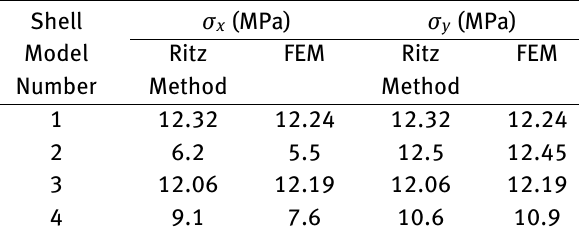
Table 2: Compressive stresses at the center of four funicular shell models under a uniformly distributed load of 85 kPa Shell